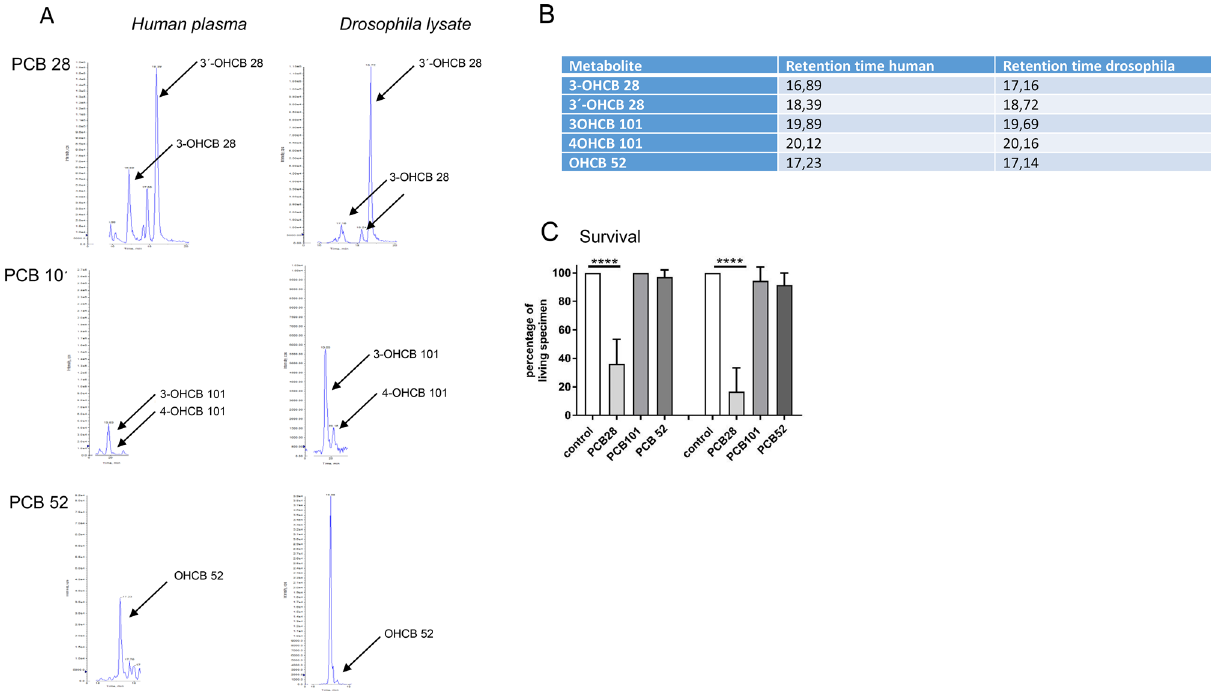
Figure 1. Cytochrome P450 monooxygenase-dependent metabolism of PCB 28, PCB 101 and PCB 52 in humans and in Drosophila melanogaster . ( A ) LC–MS/MS chromatogram of 3-OH-2 ′ ,4,4 ′ -trichlorobiphenyl (3-OHCB 28), 3 ′ -OH-4 ′ ,4,6 ′ -trichlorobiphenyl (3´-OHCB 28), 3-OH-2,2 ′ ,4 ′ ,5,5 ′ -pentachlorobiphenyl (3-OHCB 101), 4-OH-2,2 ′ ,4 ′ ,5,5 ′ -pentachlorobiphenyl (4-OHCB 101) and 4-OH-2,2 ′ ,5,5 ′ -tetrachlorobiphenyl (4-OHCB 52). Left panel, representative samples from individuals occupationally exposed to high levels of the respective PCB. Right panel, whole fly lysates from Drosophila melanogaster which were fed with a low dose (20 µM) of the respective PCBs for 24 h. One representative sample from several experiments is shown. ( B ) Corresponding retention times of targeted metabolites in human plasma and Drosophila melanogaster as shown in 1A. ( C ) Survival of Drosophila melanogaster fed with a high dose (100 µM) of PCB 28, PCB 101 and PCB 52 for 48 h and 72 h. Mean ± SD of 3 different biological experiments each with 3 technical replicates are shown (each technical replicate corresponds to 12 flies). Differences were calculated by repeated measurement ANOVA and posthoc Tukey-test. Statistical differences for PCB 28 versus control (48 h) and for 72 h were p ≤